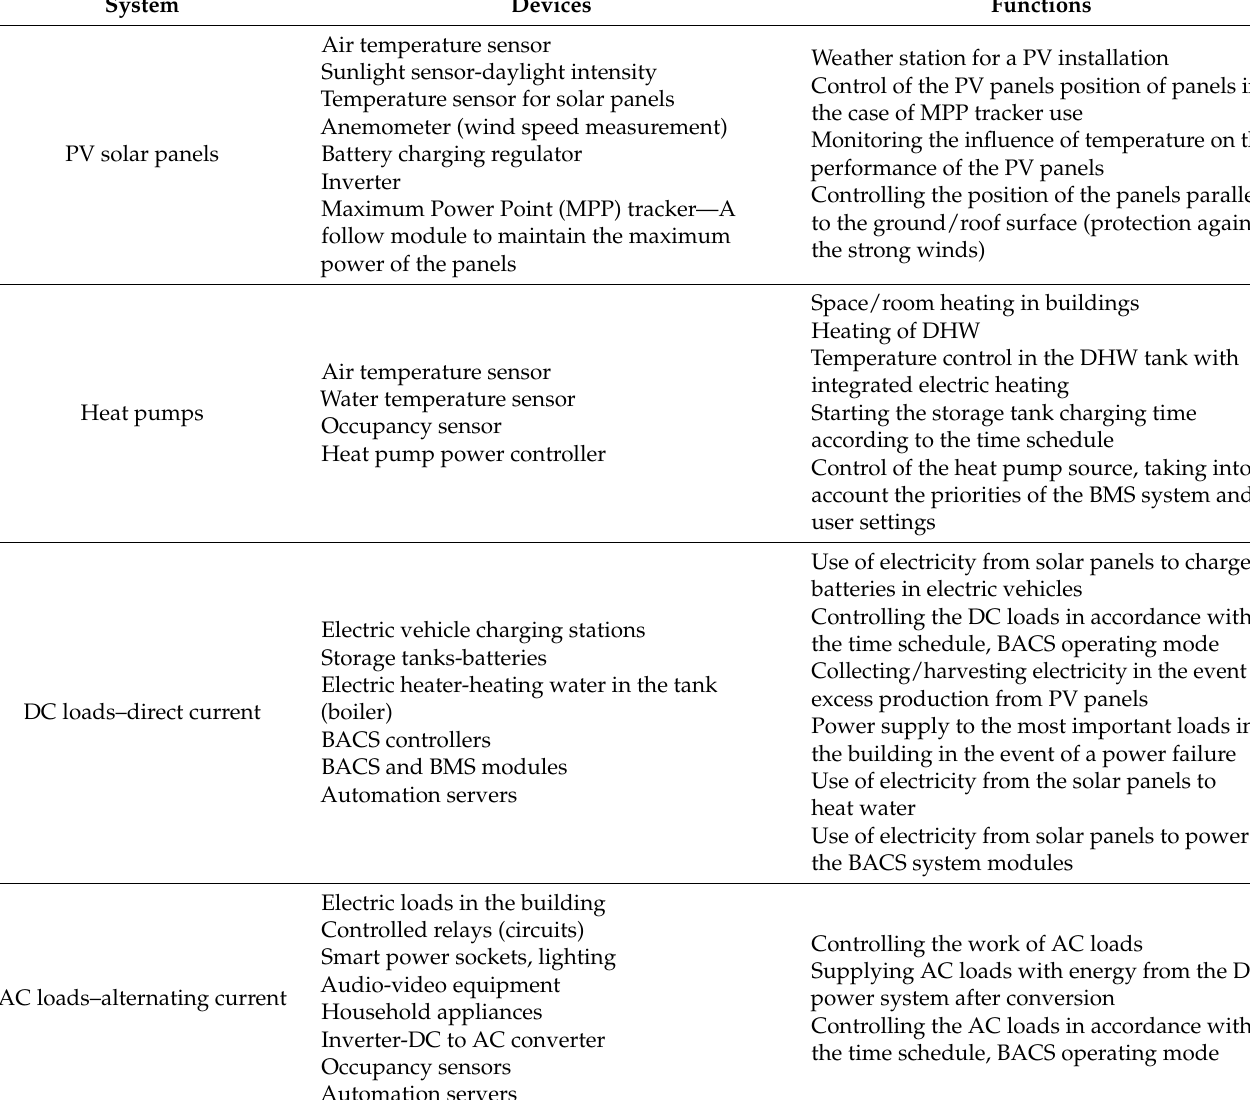
Table 2. Set of design assumptions for the BACS devices and utility as well as automation functions for a small prosumer installation (the original author’s